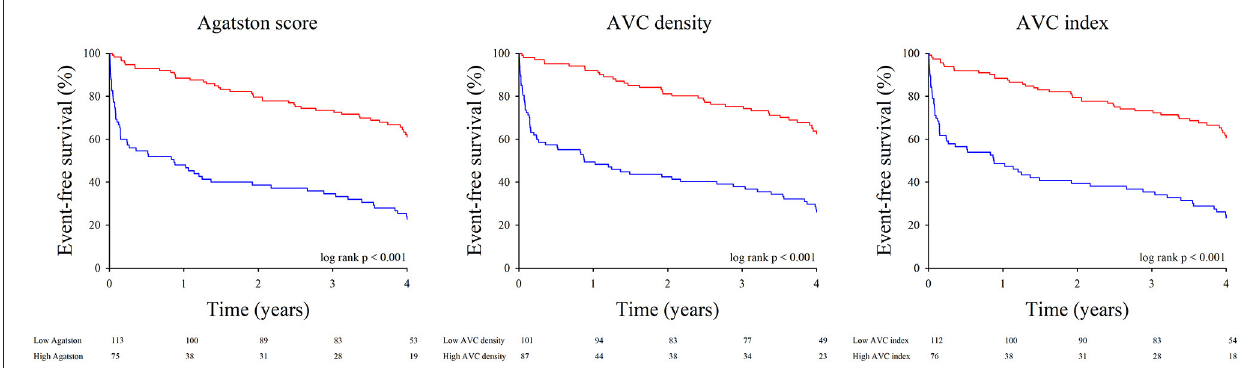
FIGURE 4 | Event-free survival according to AVC load. Kaplan-Meier survival curves for the combined end-point of death and need for aortic valve replacement in patients with low (red line) and high (blue line) AVC load. Left panel: Agatston score; middle panel: AVC density; right panel: AVC index.